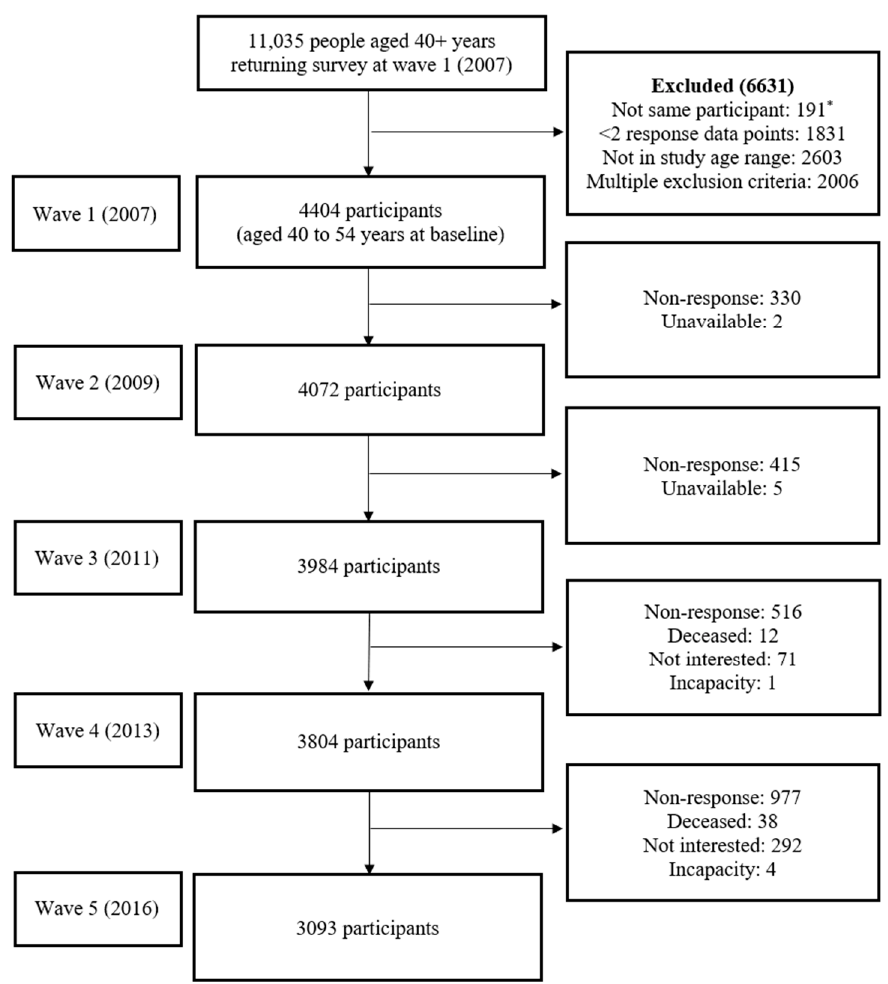
Figure 1. Flowchart of derived analytic sample of mid aged adults. * Longitudinal inconsistencies in the dataset (e.g., changes in gender) were assessed, and only those who were indicated to represent a single respondent across waves were included in analyses. Note: All participants were sent the questionnaire at each timepoint (even if there was no response previously) with the exception of participants who were deceased, and those who advised that they were not interested in study participation, unavailable (e.g., travelling overseas) or incapable due to a physical or mental condition. Non-response indicates the questionnaire was not returned or was returned without any